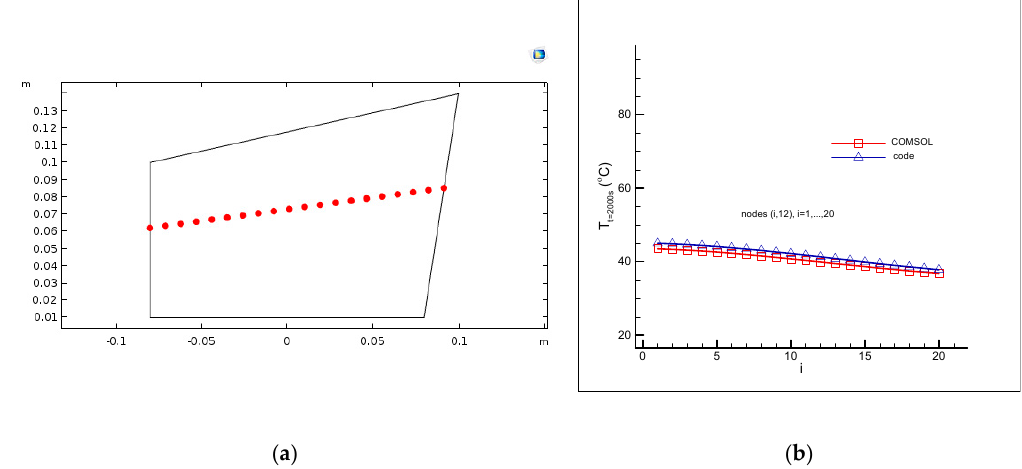
Figure 5. Comparison of temperature at nodes ( i , j ) , i = 1, ... , M ; j = 12 at the final time t f = 2000s obtained from the explicit solver and the finite-element software COMSOL. The position of nodes ( a ) and the temperature comparison ( b ).